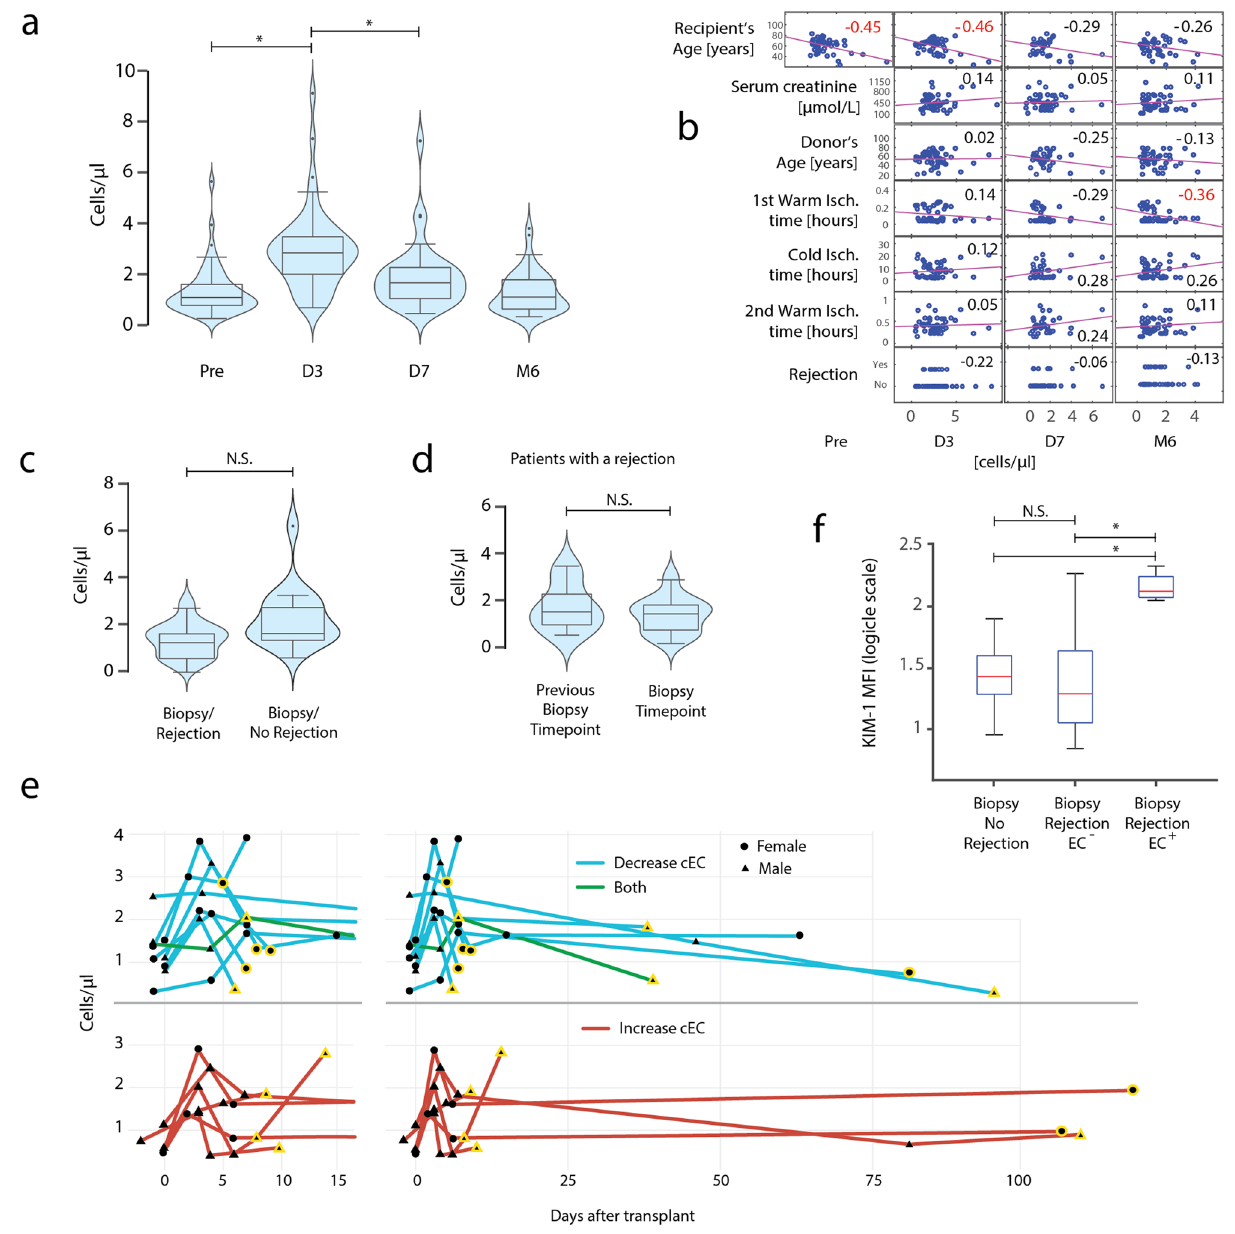
Figure 2. EC are detected in venous blood of kidney transplant recipients. (a) cEC numbers in patients for all measured time points. (b) Scatter plots with correlations between numbers of cEC in measured time points and patient and donor variables. The displayed Pearson’s linear correlation coefficients indicate the slopes of the least-squares reference lines in the scatter plots. Logistic regression between numbers of EC in measured time points and rejection. The displayed logistic coefficients indicate the change in the log odds of having a rejection. Coefficients marked in red show which pairs of variables have correlations significantly different from zero (p < 0.05). (c) Numbers of cEC at the time of biopsy taking in patients with and without a rejection episode. (d) Numbers of cEC in patients with a rejection episode at the time of biopsy taking compared to its respective previous measured time point. (e) cEC levels in patients with biopsy-proven rejection, classified by the change in cEC concentration compared to the previous measured timepoint. Time points where biopsies were performed are highlighted in yellow. Magnifications on the first 15 days after transplantation are shown at the left of the original plot. (f) Expression of KIM-1 (MFI values) in cEC of patients without rejection, with a rejection but without an increase in cEC, and with a rejection with an increase in cEC for the different biopsy outcomes in patients. Data are expressed as the median together with the 25th and 75th percentiles. In (a) , n = 50 for Pre, n = 49 for D2, n = 34 for D7, and n = 46 for M6; in (c) n = 17 biopsies with rejection, n = 25 biopsies with no rejection; in (d) n = 17; in (f) n = 25 biopsies with no rejection, n = 9 biopsies with rejection and decrease, n = 8 biopsies with rejection and increase in cEC; (* p. < 0.001). In a) one-way ANOVA with Student’s post hoc pair- to-pair test; in (c,d,f) Mann–Whitney U-test was